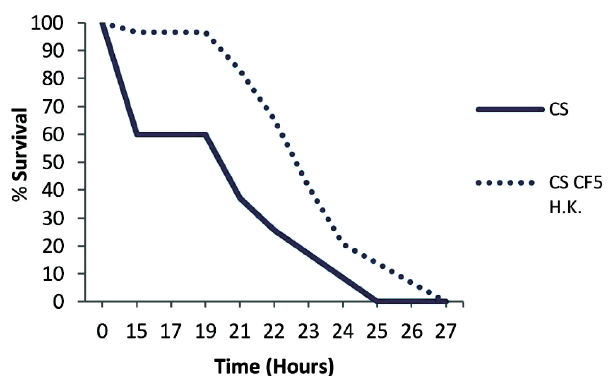
Figure 7. Survival kinetics of wt flies 5 and 7 days post priming with heat-killed Pseudomonas aeruginosa CF5. Wild type Canton S flies (CS) were primed with heat-killed CF5 cells 5 and 7 days before P. aeruginosa PA14 injection. A protective response was observed (P=0.0007) in the primed flies. n=29–35 flies per